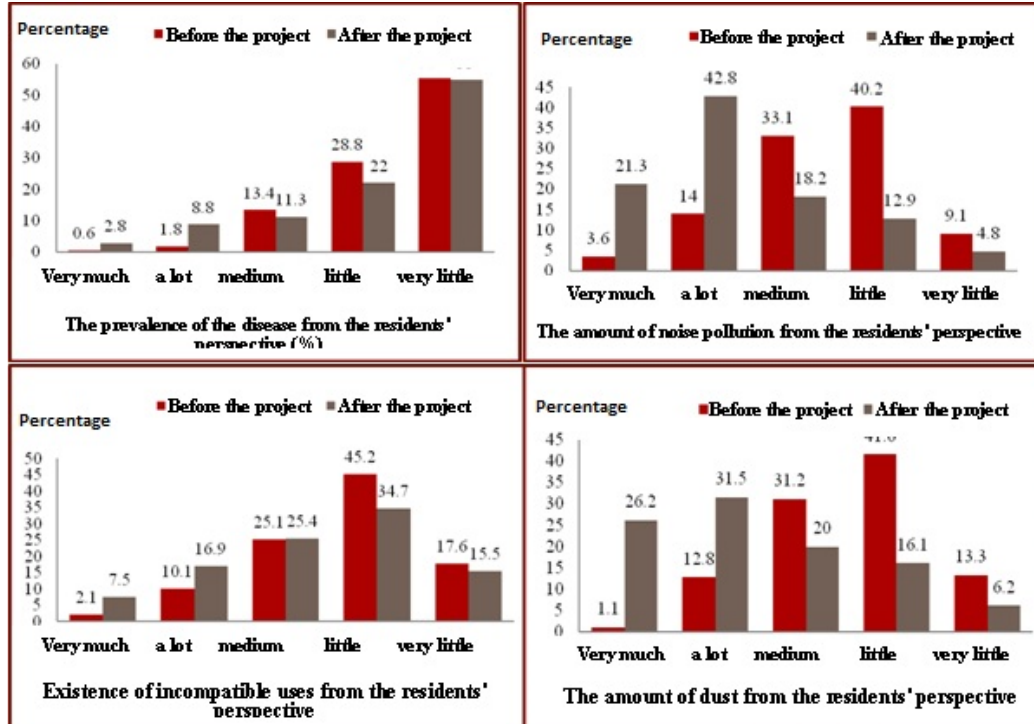
Fig. 3: Investigating the effect of Majd project on environmental indicators